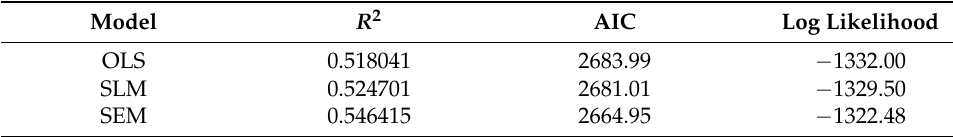
Table 3. Comparison of the OLS, SLM, and SEM models.